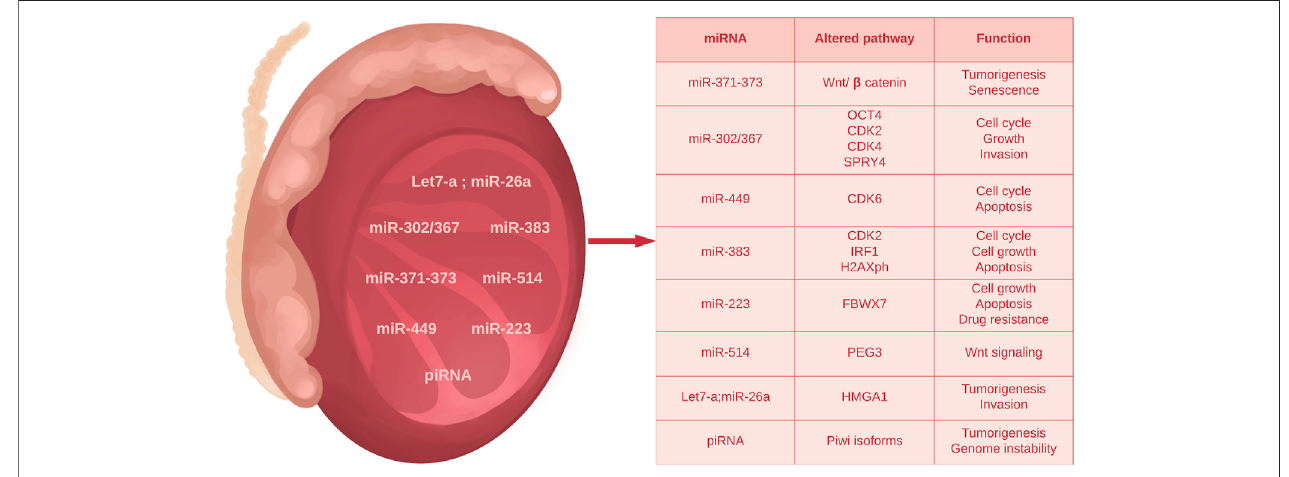
FIGURE 3 | Summary of main microRNAs and piRNAs deregulated in